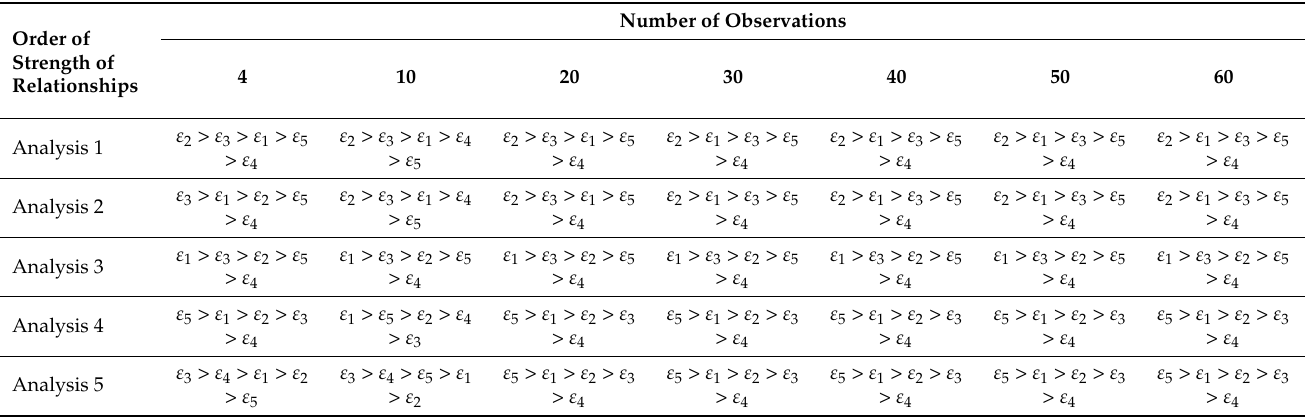
Table 2. The order of ε similarity coefficient relationships depending on the number of observations included in the